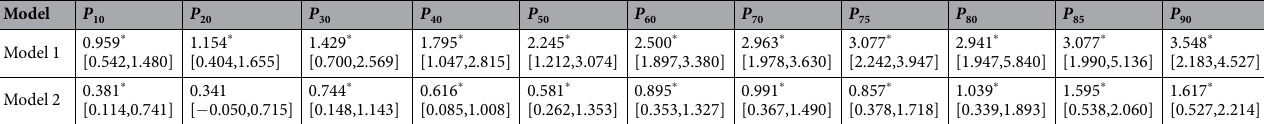
Table 3. Quantile regression coefficients [95% CI ] between FBG and SBP in males. * P < 0.05. CI : confidence interval. Model 1, without adjustments for the confounding factors. Model 2, adjusted for age, BMI, WC, smoking status, alcohol consumption and dyslipidaemia.